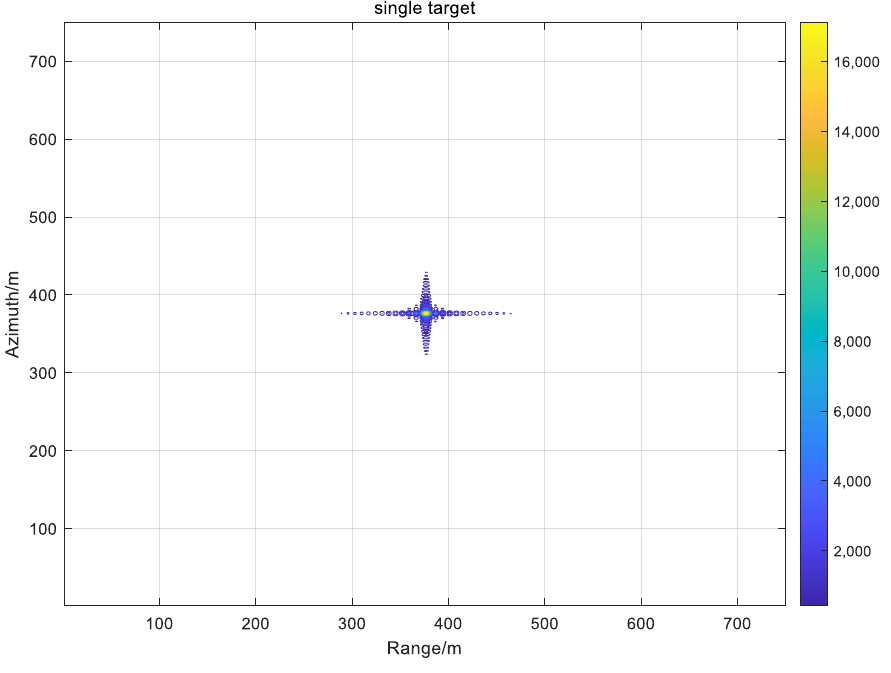
Figure 3. Single point simulation result.